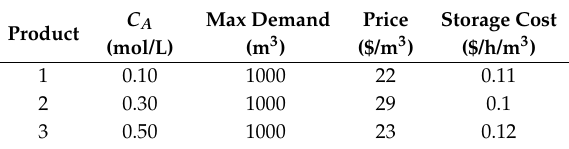
Table 4. Product